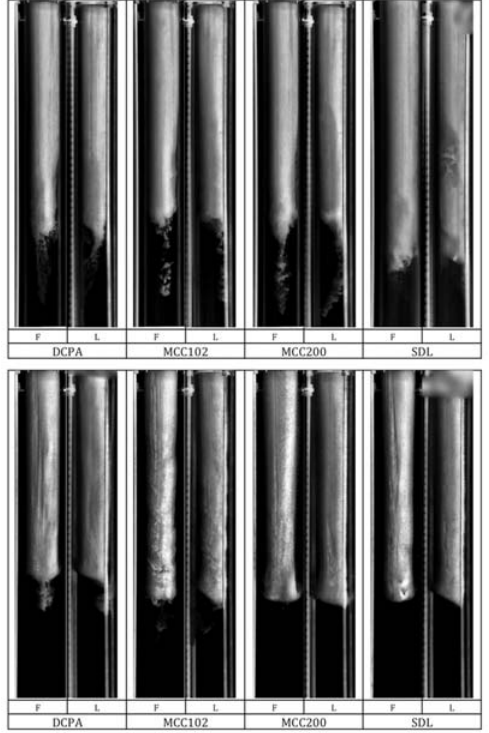
Figure 4 . Close-up photographs of the powder fall for closed outlet condition (upper 1/3 of the pipe). The top row consists of photo- graphs of spike-like structures of the first packet of detached mate- rial, while the bottom row consists of photographs of dispersed flow (approximate medium sequence section for each material). The presented images include frontal (F) and lateral (L) views of tested materials: dicalcium phosphate anhydrous (DCPA), micro- crystalline cellulose MCC102 and MCC200, and spray-dried lacto- se (SDL). The original images are inverted and the contrast enhan- ced for illustration purposes.